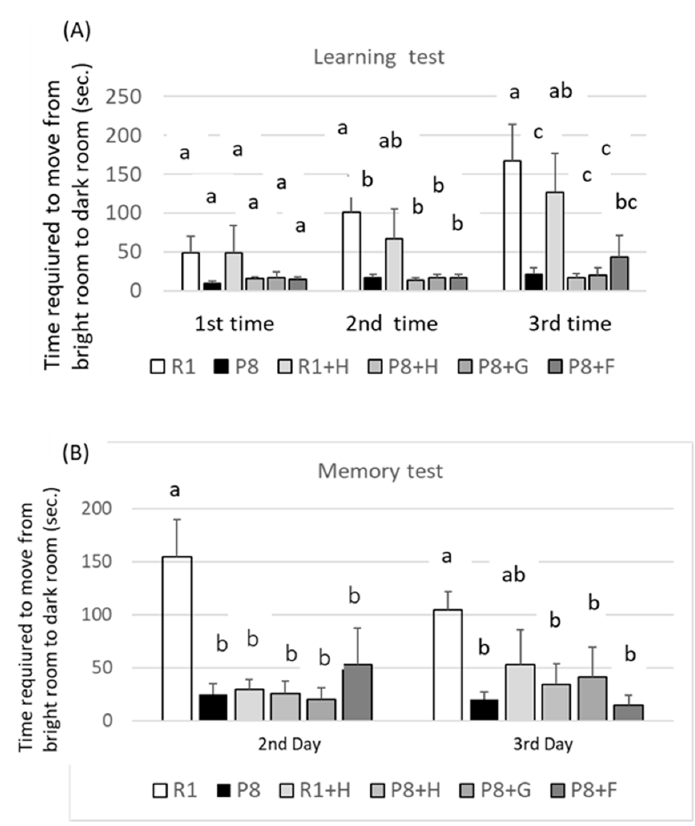
Figure 3. Effects of dietary peanut, its germ-rich fraction, and ferulic acid on the learning ( A ) and memory ( B ) abilities of SAMR1 and SAMP8. sec. in vertical line means seconds. R1: senescence-accelerated resistant mice (SAM-R1) group fed with basal diet; P8: senescence-accelerated mouse prone/8 (SAMP8) group fed with basal diet; R1 + H: SAM-R1 group fed with basal diet with added peanut wholegrain; P8 + H: SAMP8 group fed with basal diet with added peanut wholegrains; P8 + G: SAMP8 group fed with basal diet with added germ-rich fraction of wholegrain; P8 + F: SAMP8 group fed with basal diet with added ferulic acid. Groups without a common letter di ff er significantly ( p <